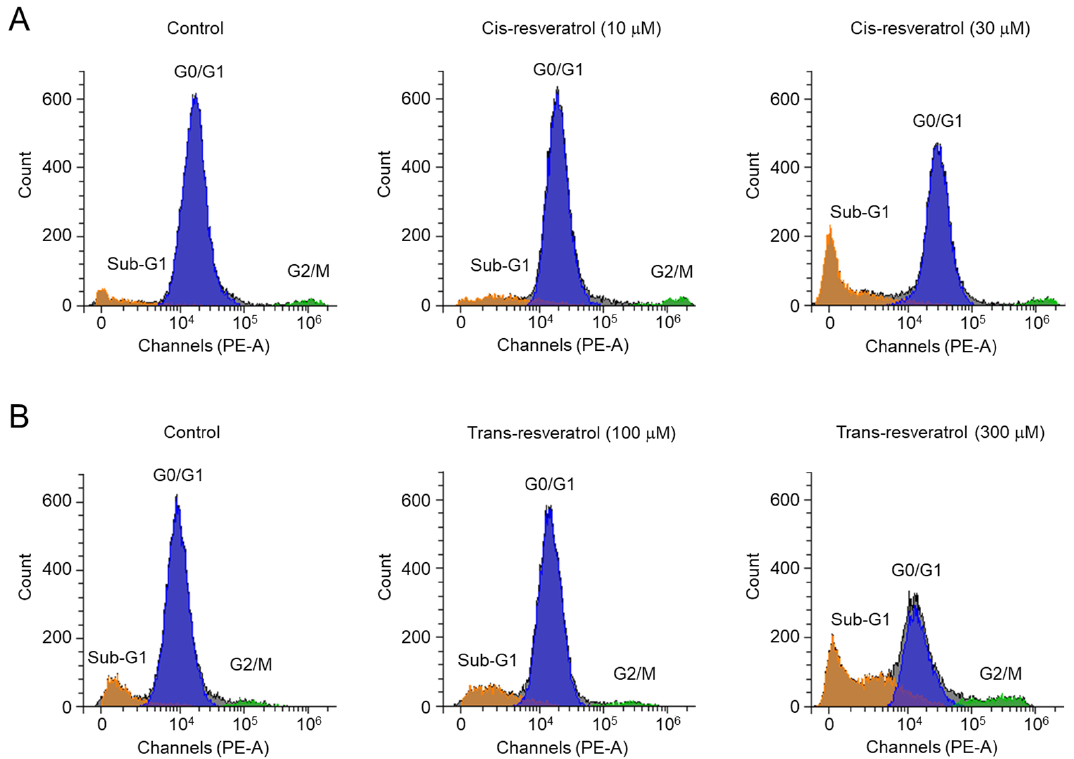
Figure 7. Effect of cis - and trans -resveratrol on cell cycle in PC-3 cells. ( A , B ) Cell cycle phases were observed by propidium iodide staining followed by flow cytometric analysis after the cells were treated with the indicated concentrations of cis - and trans -resveratrol for 48 h.